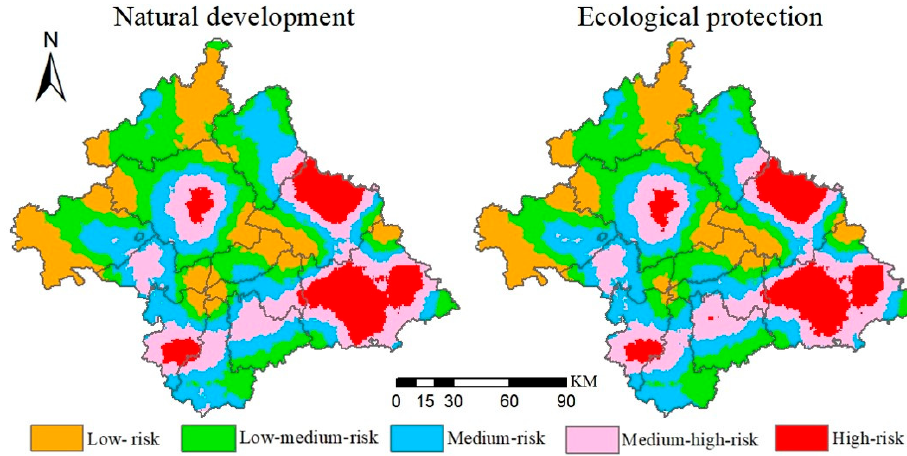
Figure 9. The ecological risk prediction for Nanning in